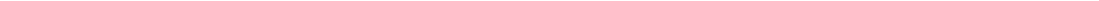
cytometry 8 days after NP exposure and cell expansion. Data represent two independent experiments conducted in triplicate. k Cellular fold expansion of CD34 − (differentiated) and CD34 + CD133 + (progenitor) cells. Bar graphs show mean and SE of three independent experiments. Data represent two independent experiments conducted in triplicate. l Colony forming unit outputs of untransfected versus MSI2-NP-transfected HSCs ( n = 3 cultures from independent donors); Pairwise differences between groups were analyzed with the unpaired, two-tailed Student ’ s t Test. * P = 0.049, ** P =